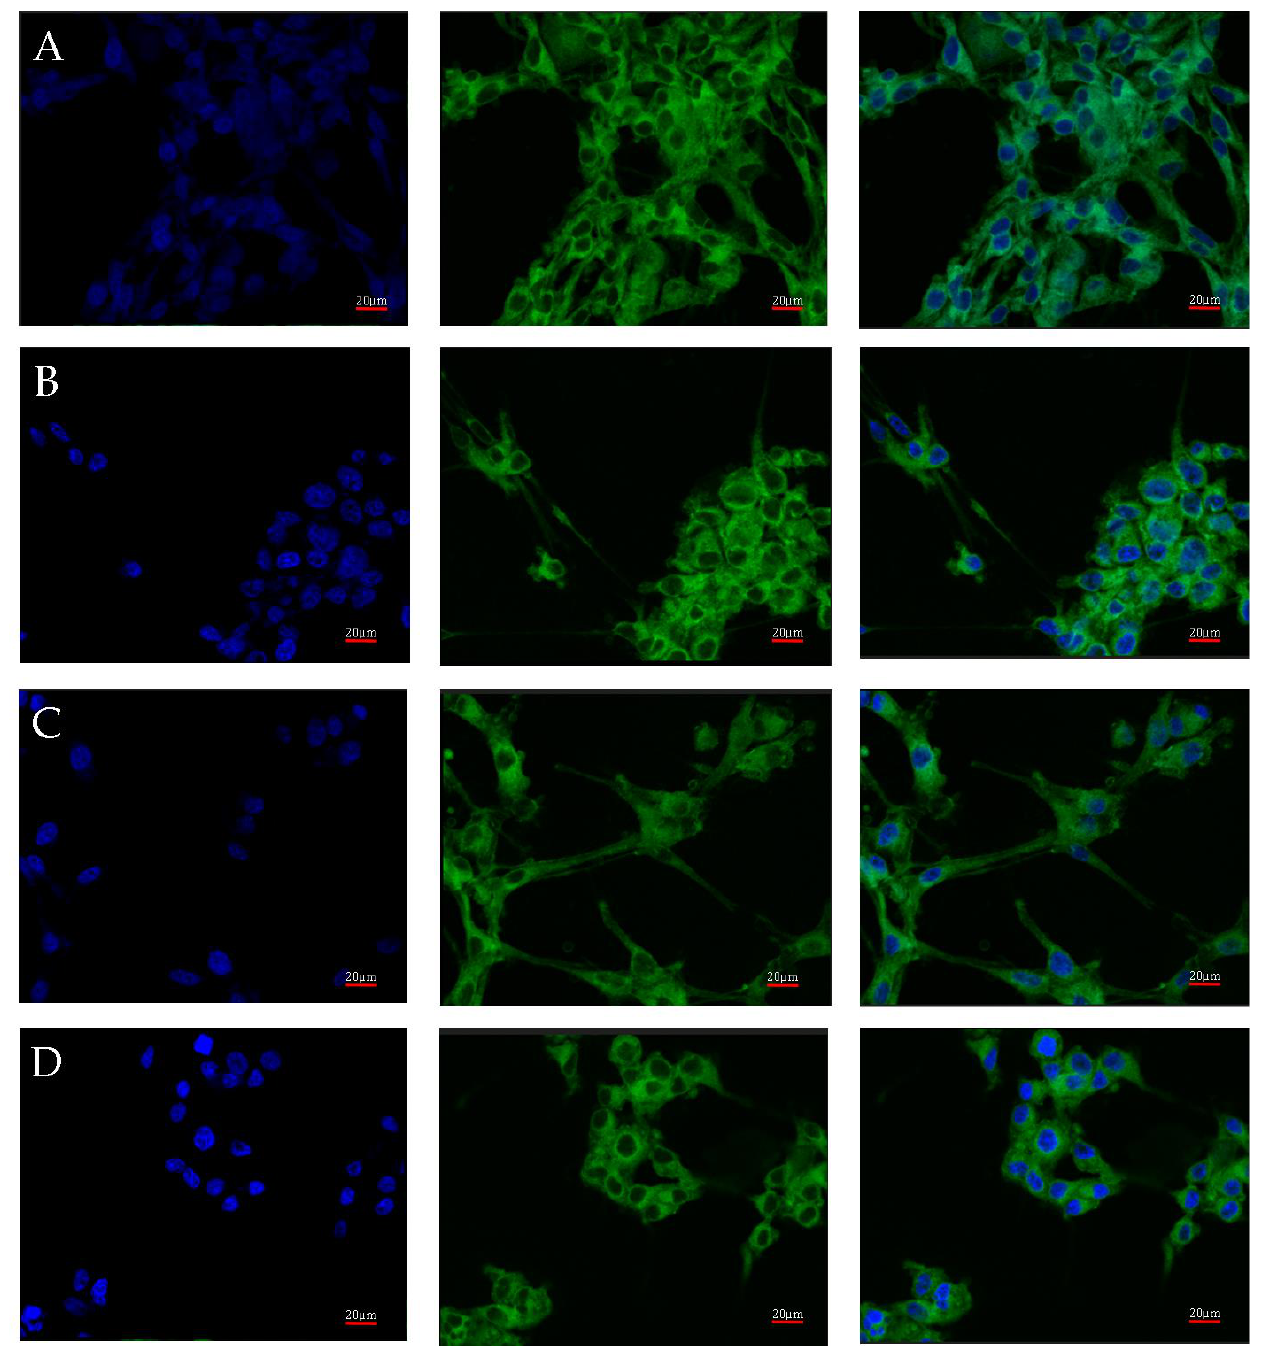
Figure 4. Representative images taken with the FV1000 confocal microscope system (Olympus, Hamburg, Germany) show AR protein expression in U87 cells cultured under specific conditions: control ( A ), nutrient deficiency ( B ), hypoxia ( C ), and necrotic conditions ( D ). FITC (AR) and DAPI (nuclear) markers were used. Micro-photographs were taken at ×20 magnification; scale bar 20 µm.